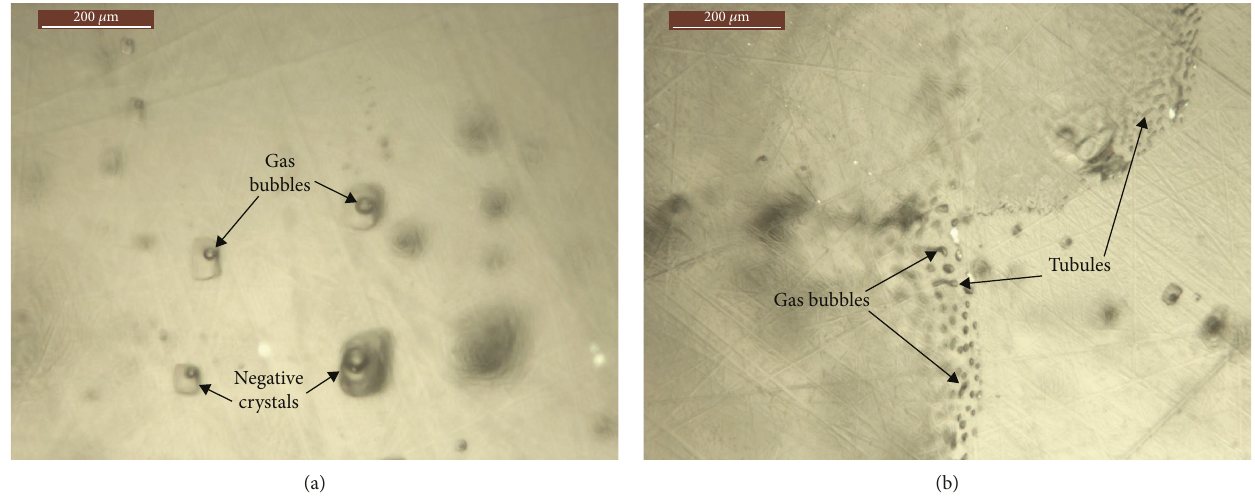
Figure 1: Gas in bubbles in undeformed WIPP salt; (a) intragranular fl uid inclusions and (b) along healed grain boundaries, transmitted light.